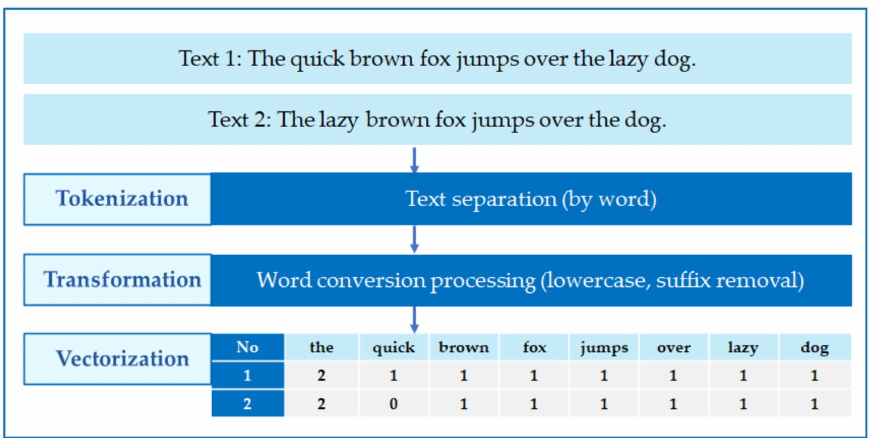
Figure 9. Corpus count